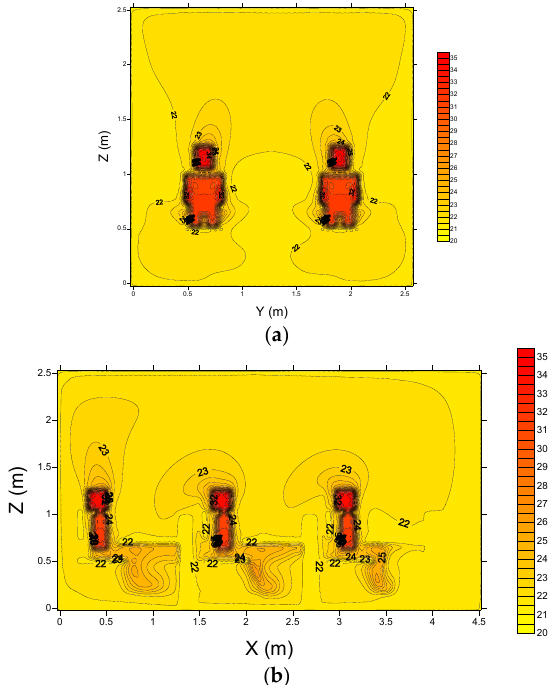
Figure 8. Air temperature field in the virtual classroom with 6 occupants in the plans ( a ) X = 1.791 m and ( b ) Y = 0.63099 m, with an inlet air temperature of 20 °C.